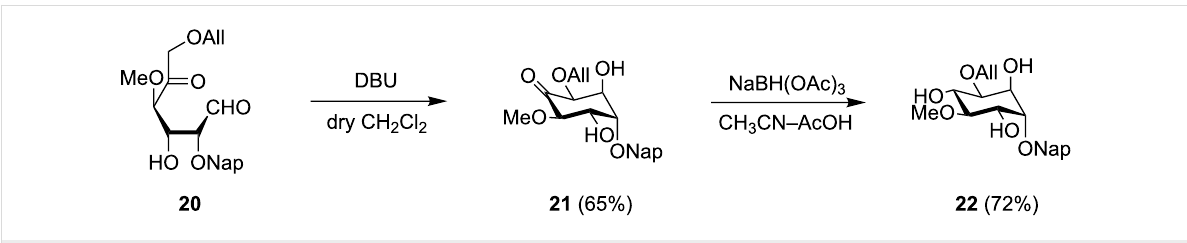
Scheme 2: Intramolecular cyclization of an orthogonally protected L- lyxo -aldohexos-5-ulose